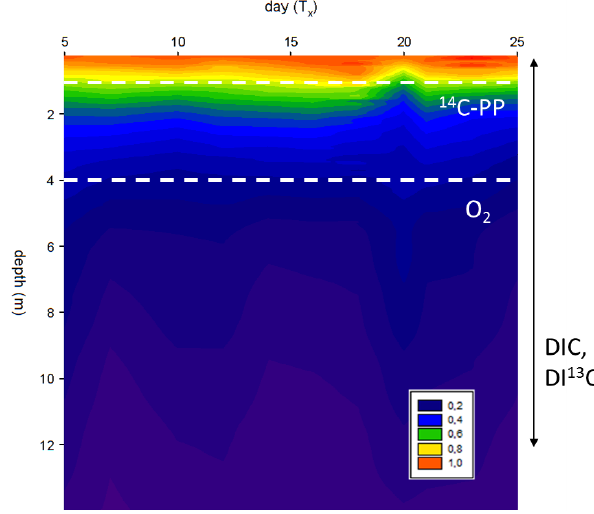
Fig. 2. Fraction of surface light received at different depths in the mesocosms in the course of the study as exemplified for M1. For comparison, bottle incubations were performed at 1m depth ( 14 C incubations) and at 4m depth (O 2 , Tanaka et al., 2013), while changes in DIC concentration were calculated from depth-integrated water sampling (0–12m; de Kluijver et al., 2012; Silyakova et al.,